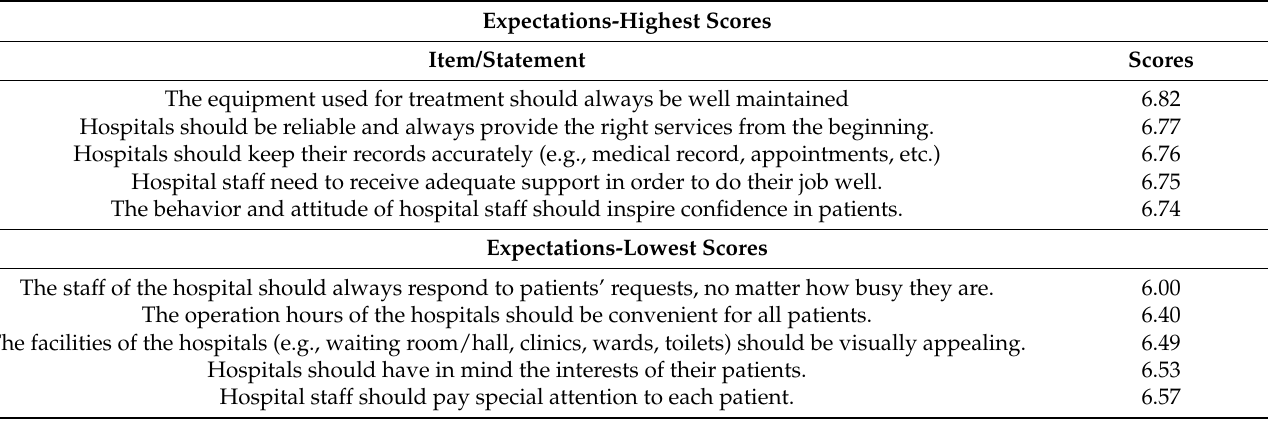
Table 4. Statements with the highest and lowest scores on